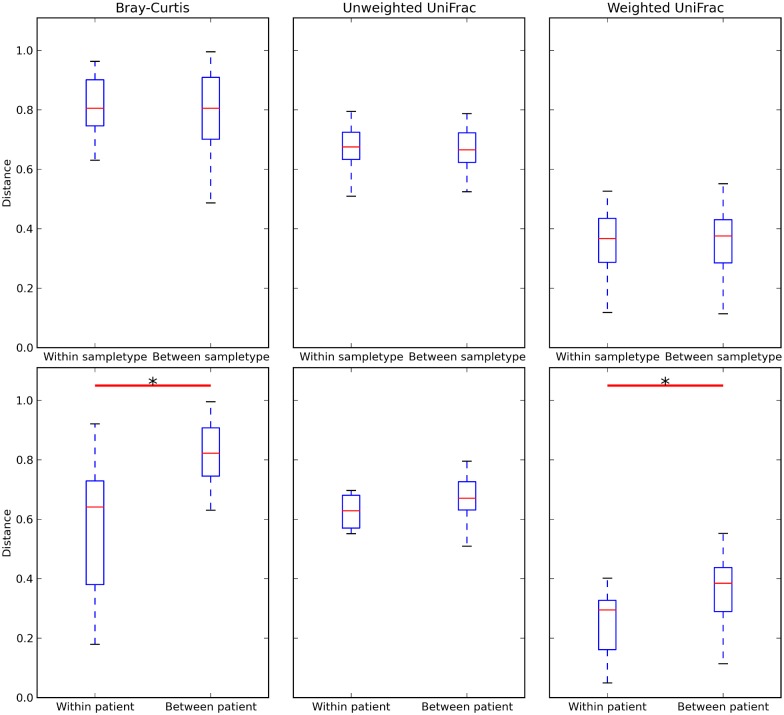
Boxplots showing distances from Bray-Curtis, unweighted UniFrac, and Weighted UniFrac distance matrices.Boxplots show no significant difference between within-sampletype and between-sampletype distances, and a statistically significant difference between within-patient and between-patient Bray-Curtis and Weighted UniFrac distances. Whiskers extend to cover the whole range of values. * = p < 0.05 (two-tailed Student's t-test, computed through QIIME’s script make_distance_boxplots.py).